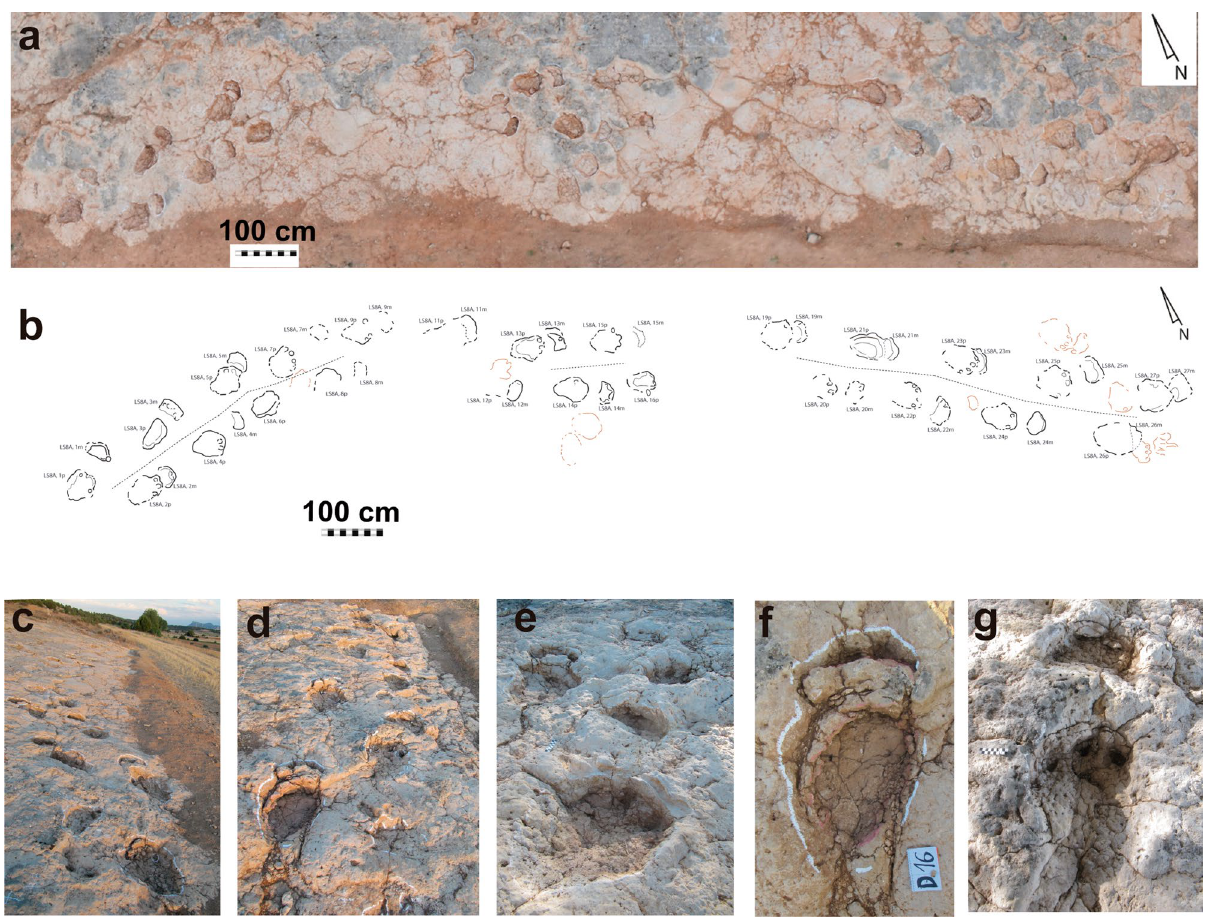
Figure 2. Las Sereas 8 tracksite. Tracks of Iniestapodus burgensis : ( a ) Ortophoto of LS8A trackway; ( b ) Interpretative cartography of LS8A trackway; ( c ) Initial section of LS8A trackway, from LS8A,1p to LS8A,7p; ( d ) Final section of LS8A trackway, from LS8A,20m to LS8A,27m; ( e ) A detail of the tracks LS8A,4p/ m; LS8A,5p/m; LS8A,6p; and LS8A,7p; ( f ) Pair LS8A,21p/m; ( g ) Pair